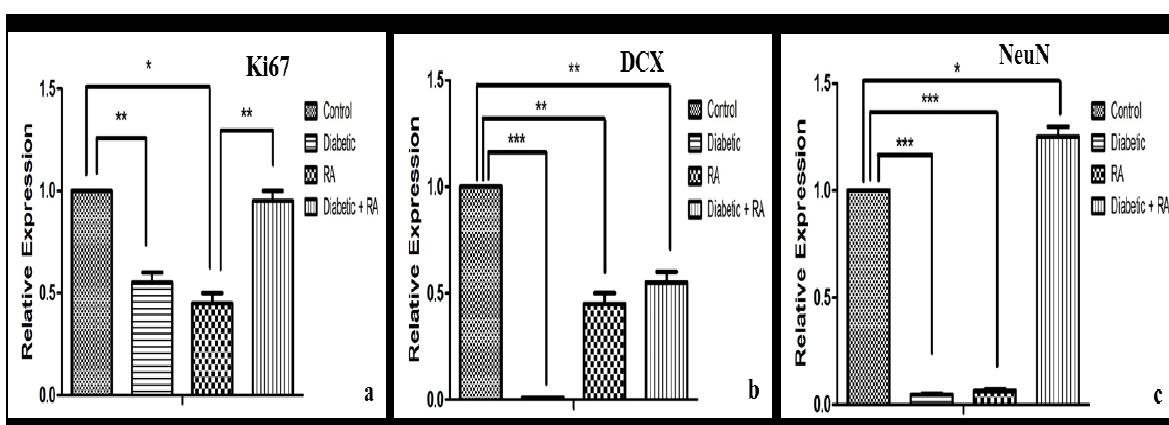
FIGURE 4 - Histogram Representing the Relative Expression of Ki67, DCX and NeuN in Control and Experimental Groups: Decline in the expression of (a) Ki67, (b) DCX and (c) NeuN in the diabetic mice shows an impaired neuronal proliferation capability. A substantial increase after the RA treatment shows its promising influence on neuronal proliferation. The data was analyzed using one-way ANOVA and is shown as mean ± SEM, * p < 0.05 **, p < 0.005 and *** p < 0.0005